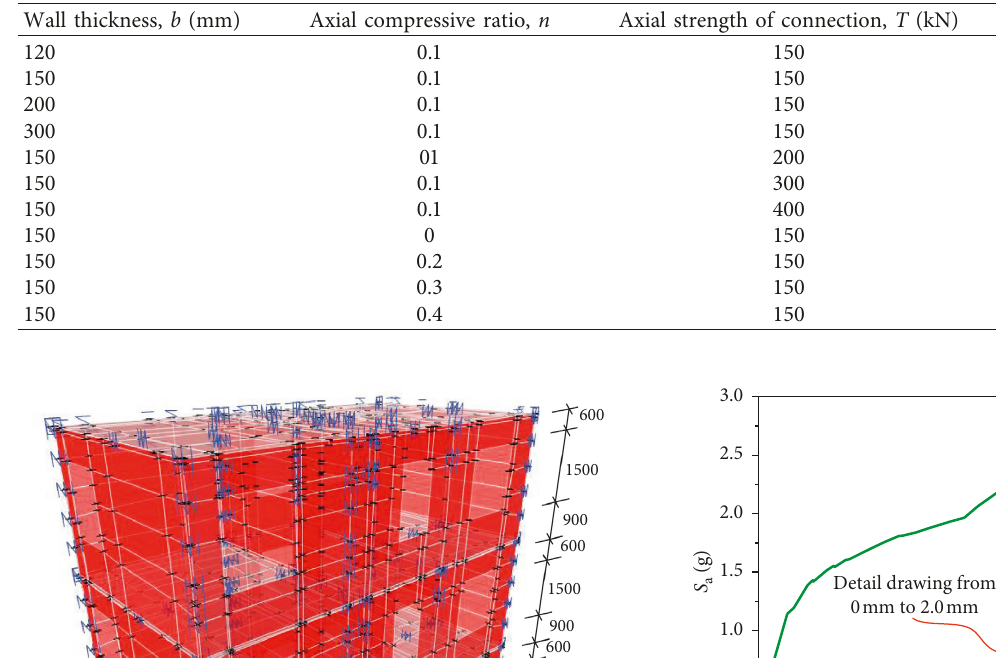
Table 5: Comparison of shear capacity for different parameters.